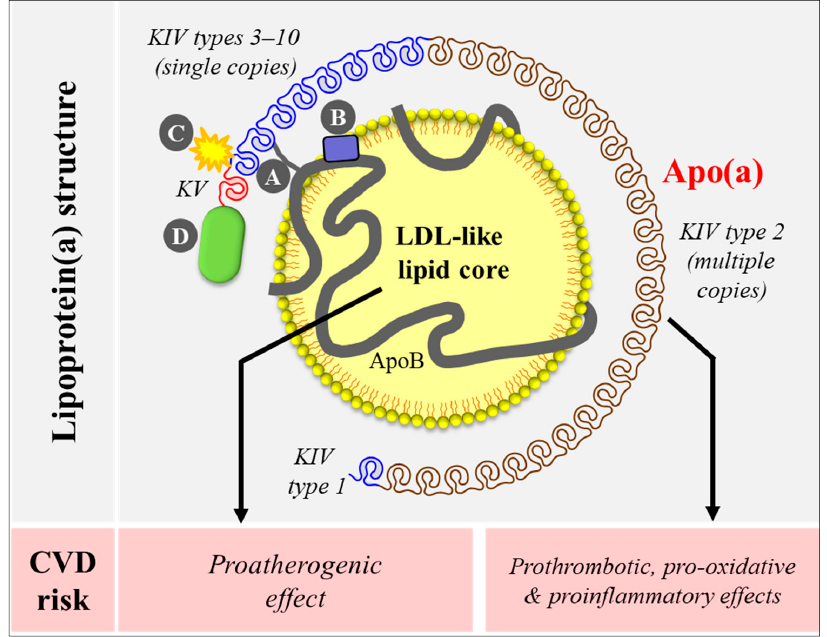
Figure 1. Lipoprotein(a) [Lp(a)] structure and potential mechanisms underlying cardiovascular risk. Lp(a) contains an LDL-like core and one molecule of apolipoprotein(a) (apo(a)). Apo(a) binds to apoB-